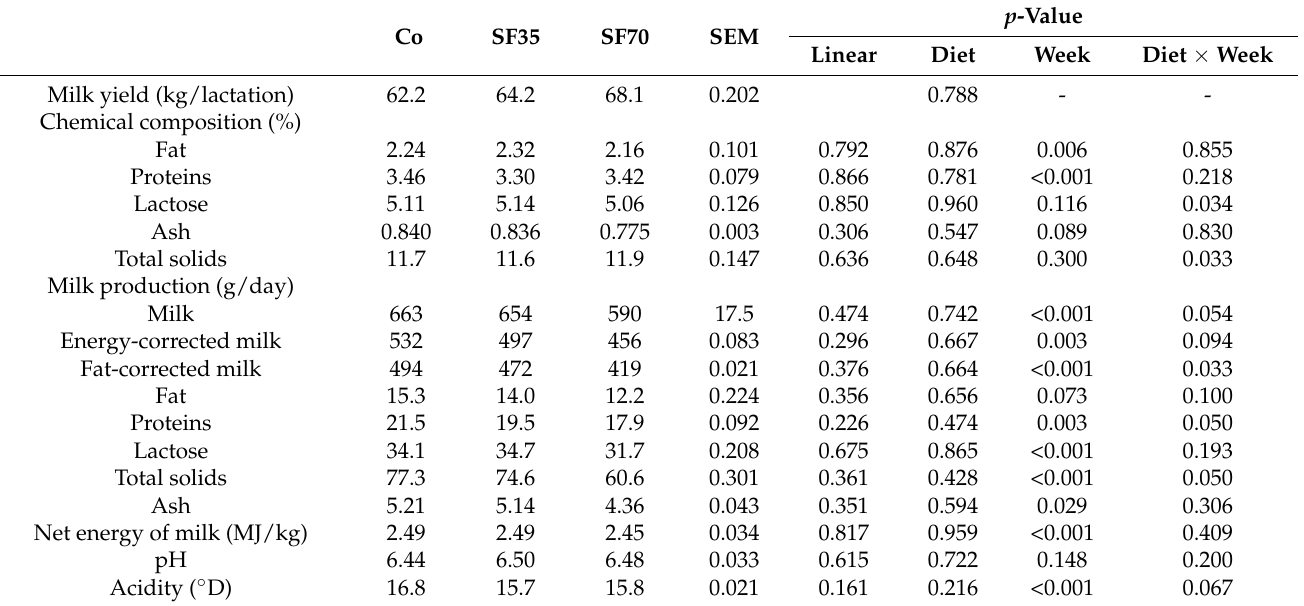
Table 4. Least square means of production, composition, acidity, and net energy of goat milk according to diet ( n = 80 for each group).